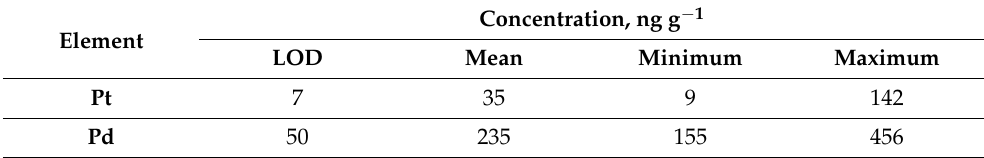
Table 2. Concentrations of Pt and Pd in road dust as obtained by ICP-MS. Element